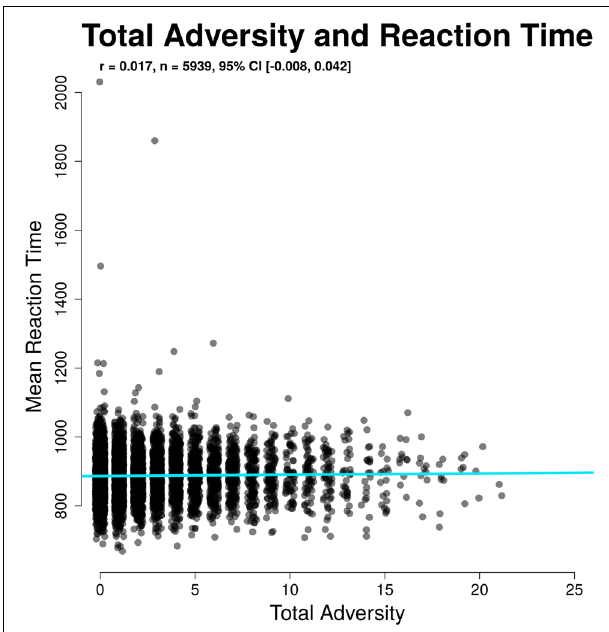
FIGURE 5 | Non-significant relation between adversity and mean RT on correct trials.